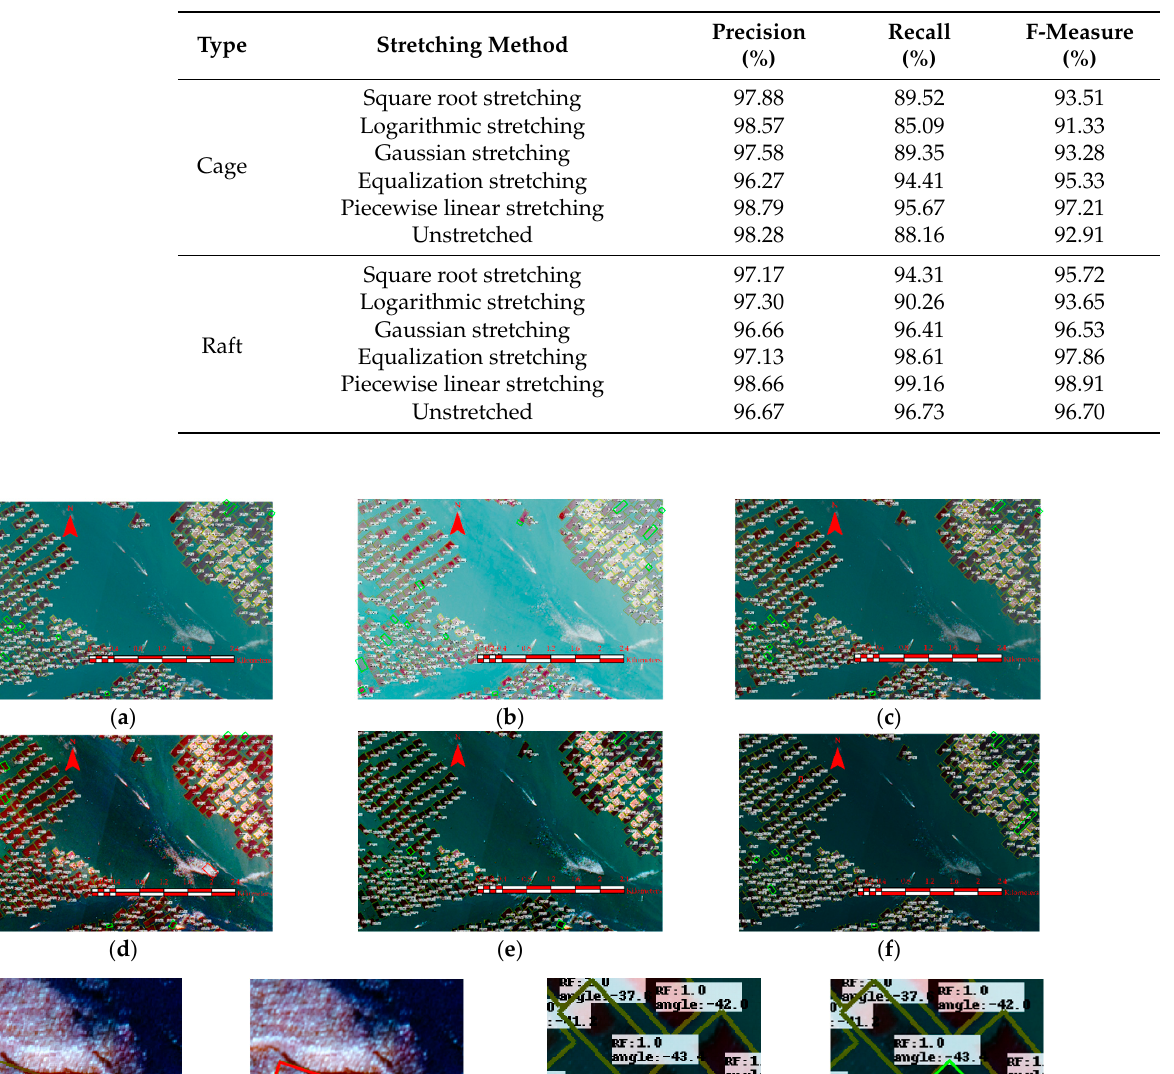
Table 5. Comparisons of extraction cage and raft aquaculture zones under different image stretching conditions by R 3 Det.